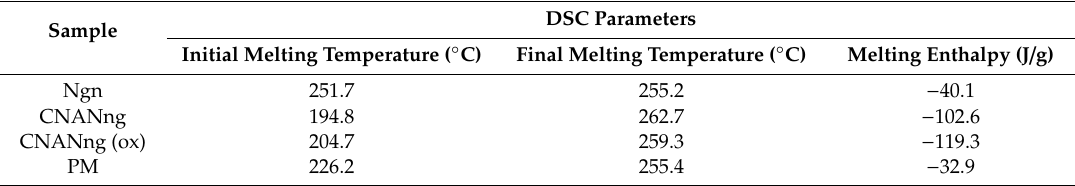
Table 1. Thermal parameters obtained from the DSC